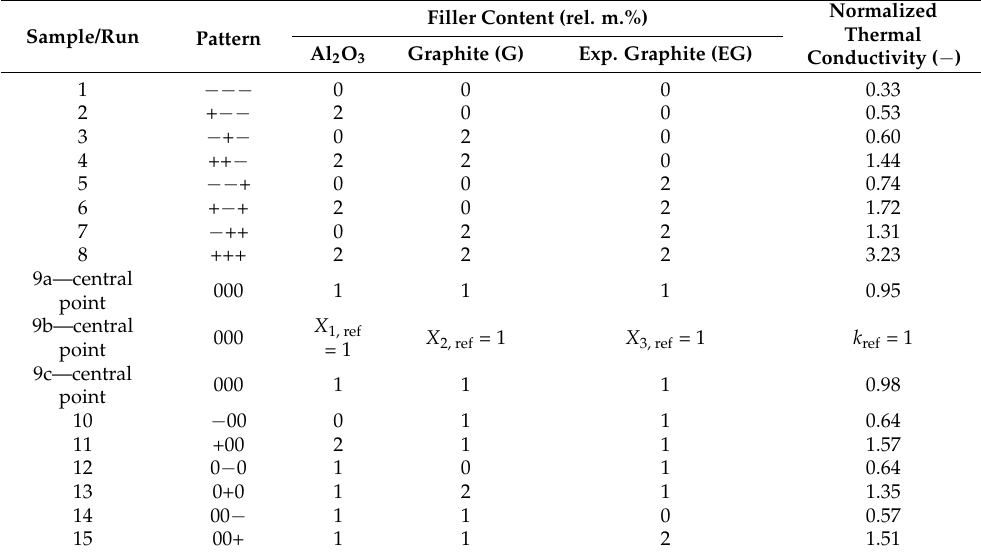
Table 2. Thermal conductivity results; relative data as normalized vs. reference values. Filler Content (rel. Sample/Run Pattern